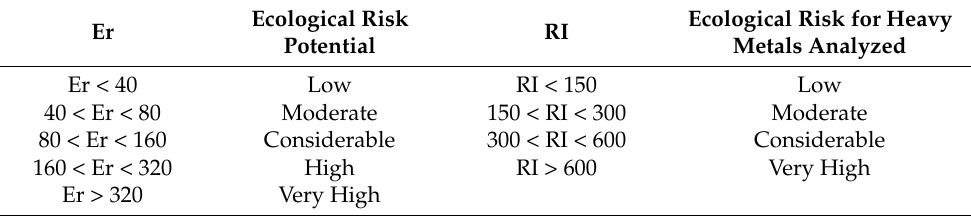
Ecological Risk for RI